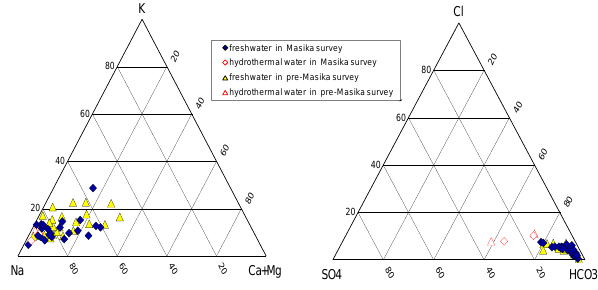
Fig. 3. Ternary plot showing the study area groundwater composi- tion. The (Ca+Mg)-Na-K ternary plot is shown on the left, and the HCO 3 -SO 4 - Cl one on the